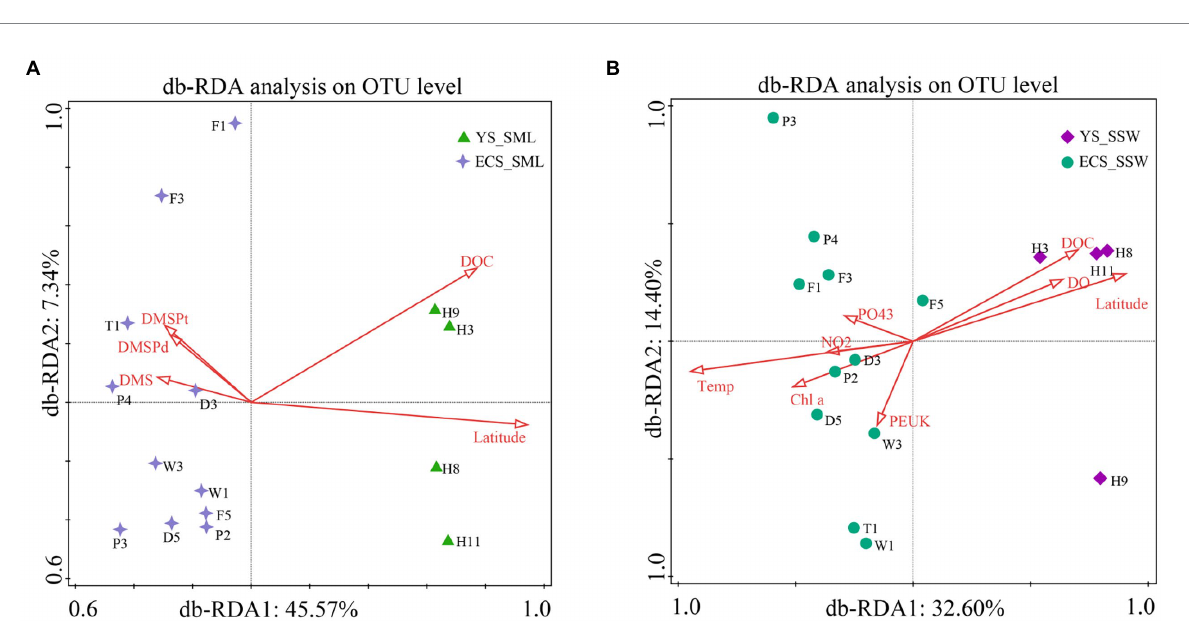
FIGURE 4 db-RDA analysis showing the relationship between bacterial community and environmental factors of the SML and SSW in the East China Sea and the Yellow Sea in summer. (A) , db-RDA analysis of the SML samples; (B) , db-RDA analysis of the SSW samples. YS_SML, the Yellow Sea SML samples; ECS_ SML, the East China Sea SML samples; YS_SSW, the Yellow Sea SSW samples; ECS_SSW, the East China Sea SSW